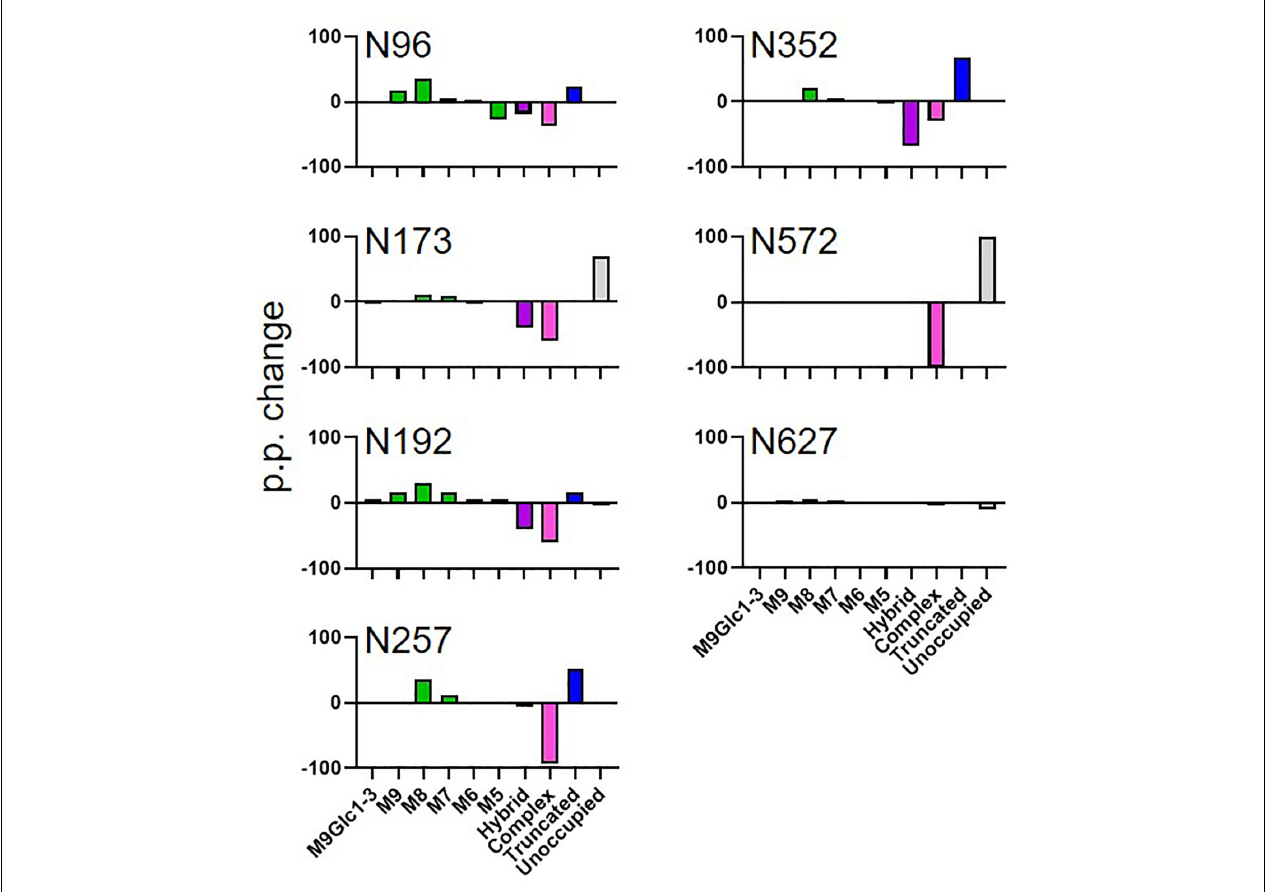
FIGURE 3 | Comparison of MARV GP (cid:49) TM glycosylation when the protein was expressed in plants and mammalian cells. The data represent the percentage point change in glycosylation when the protein was expressed in N. benthamiana compared to HEK293, so a positive value represents a category of glycan that is enriched on material produced in N. benthamiana . Glycans are categorized according to the detected compositions by LC-MS. Compositions containing Hex(10-12) HexNAc(2) were categorized as M9Glc1-3 and Hex(9-5) HexNAc(2) as M9-M5. These are classified as oligomannose-type glycans and are colored green. Hybrid-type glycans contain compositions consisting of Hex(5)HexNAc(3)X or Hex(6)HexNAc(4)X. Remaining glycan compositions were assigned as complex-type. Any composition Hex(3) HexNAc(2) or smaller is classified as truncated. The proportion of potential N-linked glycans which are classified as unocupied are coloured